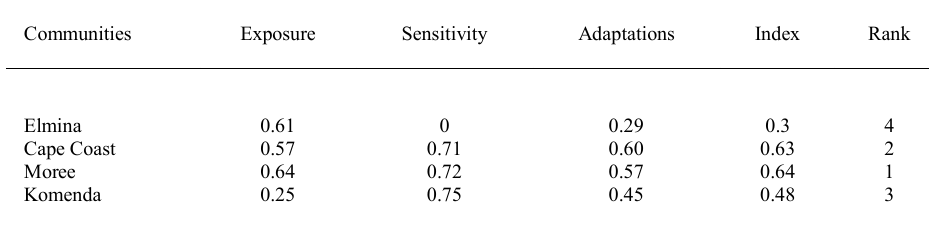
Table 6: Vulnerability index score of the communities